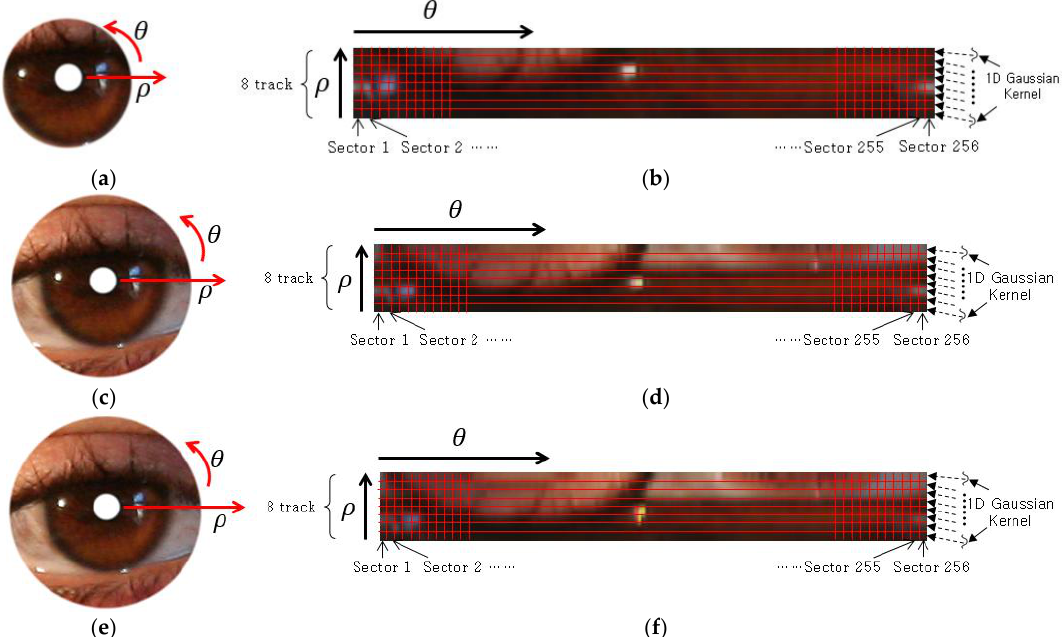
Figure 5. An example of image transformation in polar coordinates and the size normalization. ( a ) Iris region in Cartesian coordinates; ( b ) normalized image of ( a ) in polar coordinates; ( c ) periocular region based on w 1 × IRrad in Cartesian coordinate; ( d ) normalized image of ( c ) in polar coordinate; ( e ) periocular region based on w 2 × IRrad in Cartesian coordinate; ( f ) normalized image of ( e ) in polar coordinates.